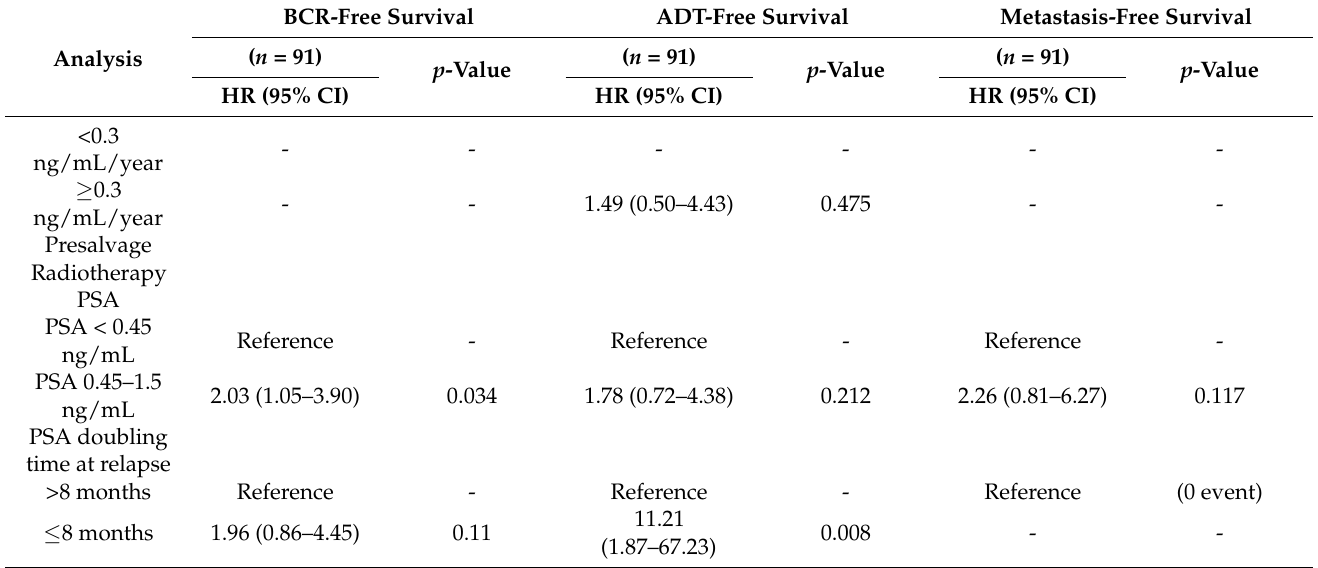
Figure 3. Nomogram to predict the 5-year ( a ) biochemical recurrence (BCR)-free probability and ( b ) metastasis-free (MSF) probability following salvage radiotherapy (SRT) for BCR after radical prostatectomy based on age at SRT, pre-SRT PSA level, PSA-doubling time (PSA-DT), surgical margins, and seminal vesicle invasion (SVI). Calibration of the nomogram for 5-year ( c ) BCR-free probability and ( d ) MSF probability. 3.5. Adverse Events of SRT During the follow-up period, adverse events of Grades 1 to 3 were reported by six (6.6%) patients. No Grade 4 or 5 events were observed. Genitourinary adverse events of Grade 2 hematuria occurred in three patients. No aggravation of urinary incontinence was observed. Only one Grade 3 treatment-related colitis, one Grade 2 proctitis, and one Grade 1 dermatitis were reported. 4. Discussion This prospective observational cohort study revealed the distinctive outcome of ap- plying SRT to the prostate bed alone without the competing effect of concomitant ADT.